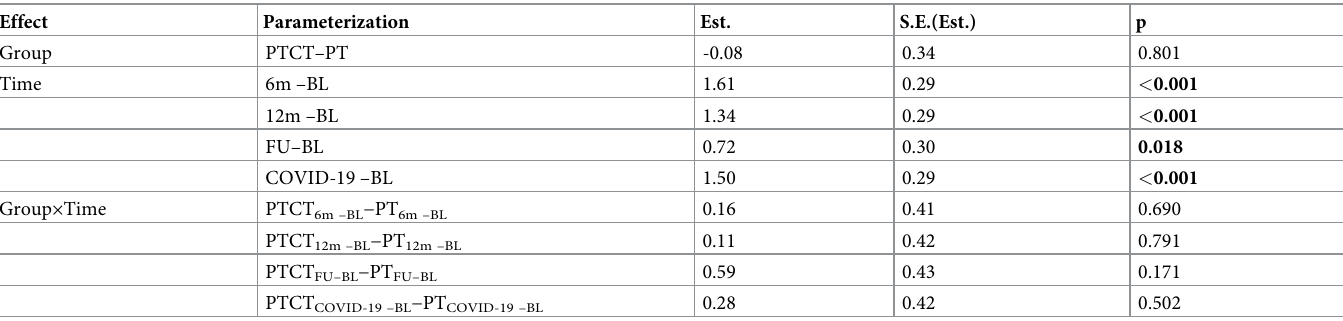
Table 3. Effect estimates in longitudinal linear multinomial model for changes in physical activity category probabilities over time points. Effect